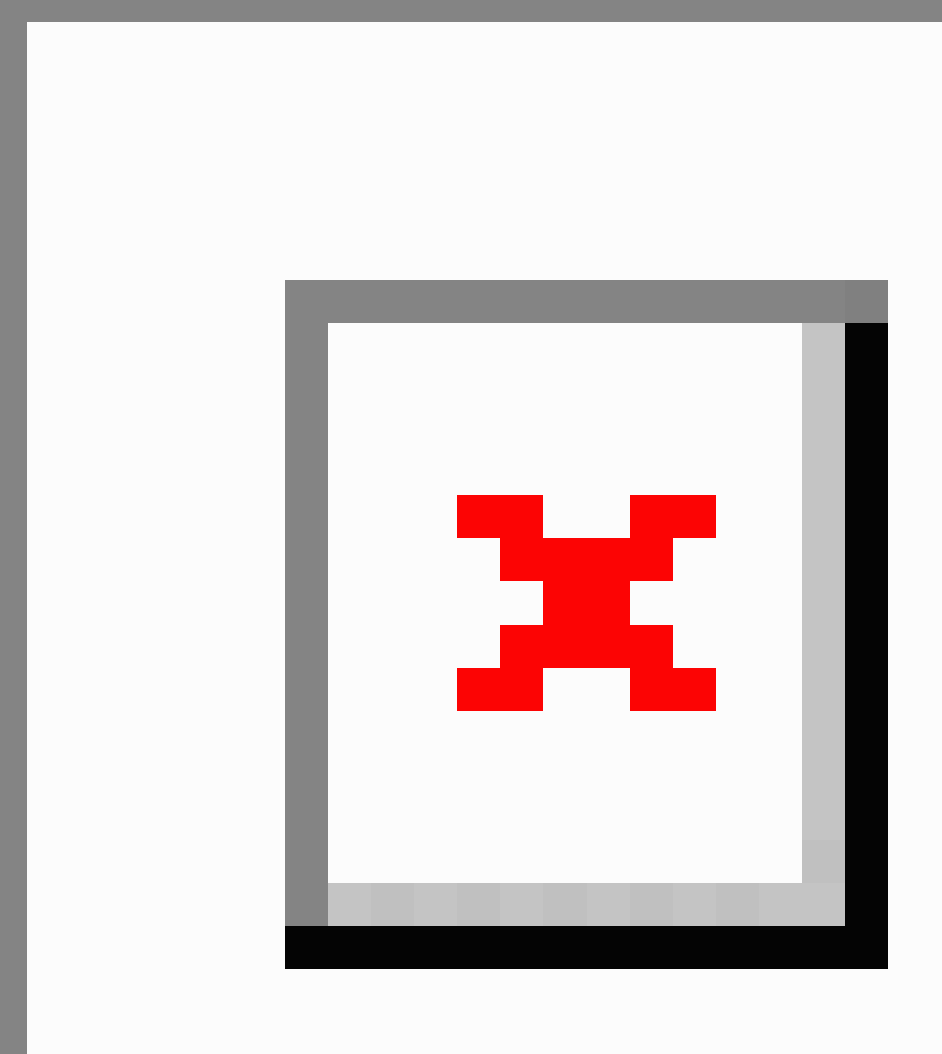
Figure 2. Screenshots of the new mobile personal health record app. (a) Dashboard. (b) Two types of tests in the Test Results section under the Health Records module. (c) A list of commonly ordered laboratory tests. (d) A list of buttons for commonly ordered diagnostic procedures. (e) A simple form for entering a typical x-ray exam result. (f) Graphical test results collected over time. (g) The page for adding a doctor’s appointment. (h) The customizable tracker